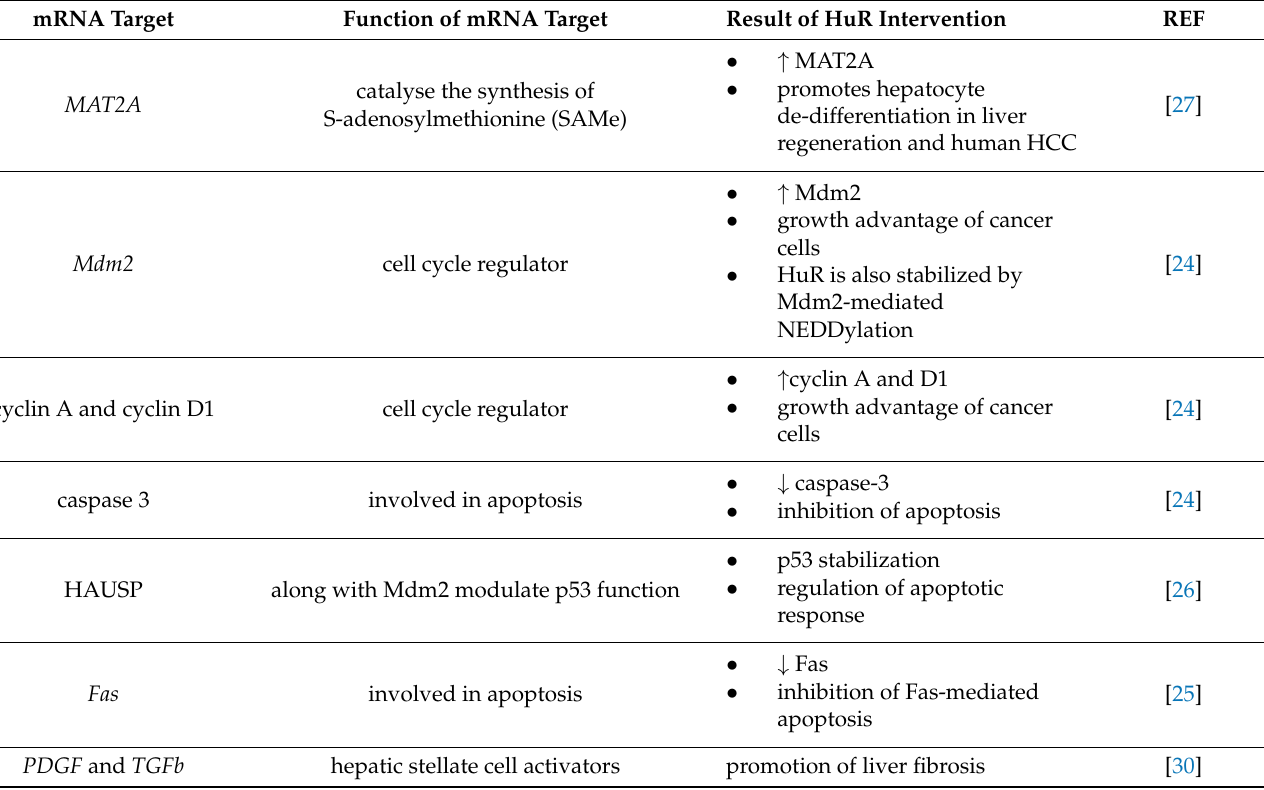
Table 1. HuR mRNA targets in liver